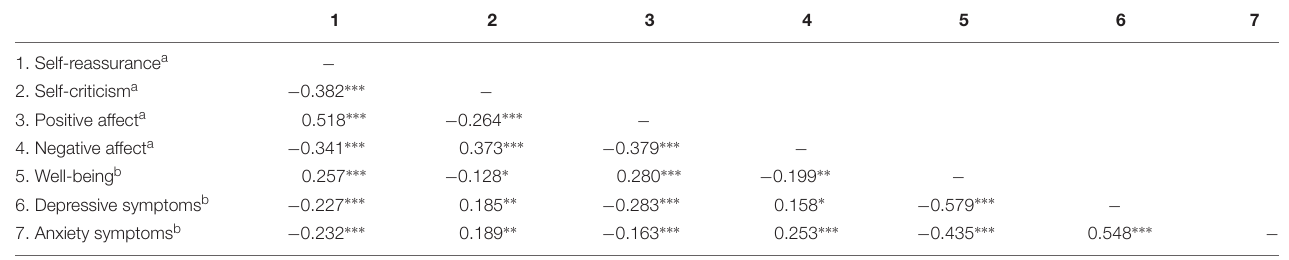
TABLE 3 | (Inter)correlations between mediating and outcome variables ( N = 242). 1 2